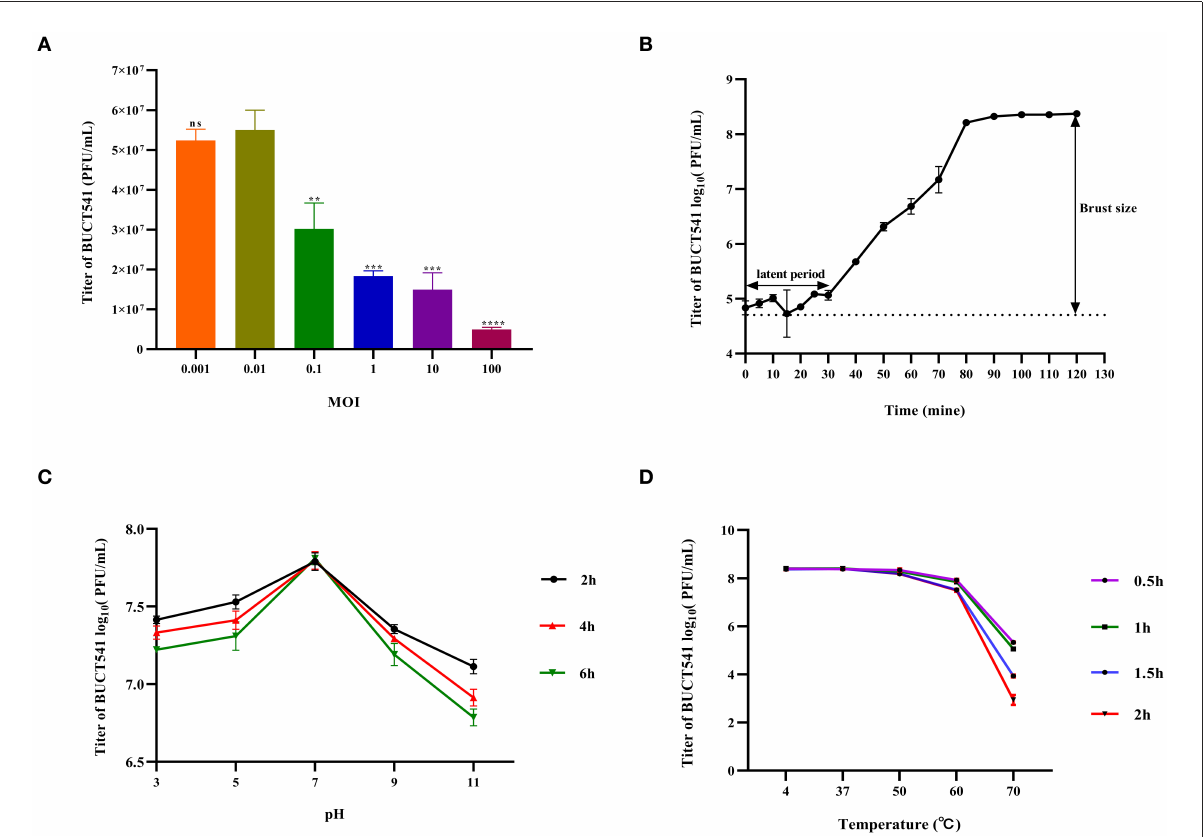
FIGURE2 Physiological characterization of phage BUCT541. (A) Optimal MOI assays of bacteriophage BUCT541 (**** P < 0.0001, *** P < 0.001, and ** P < 0.01 indicate a significant difference compared to the MOI 0.01); (B) One-step growth curve of bacteriophage BUCT541; (C) pH stability of bacteriophage BUCT541; (D) Thermal stability of